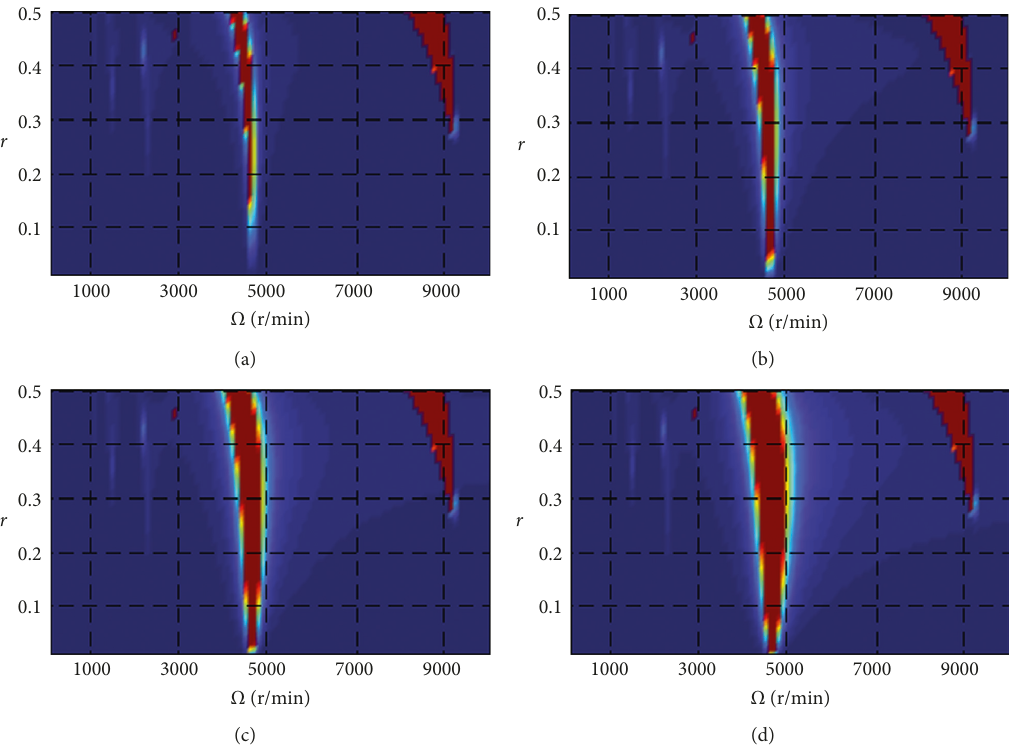
Figure 13: Average degrading rate versus crack depth ratio and rotation speed with β � 1/2 π and ζ � 0.01 for various eccentricities: